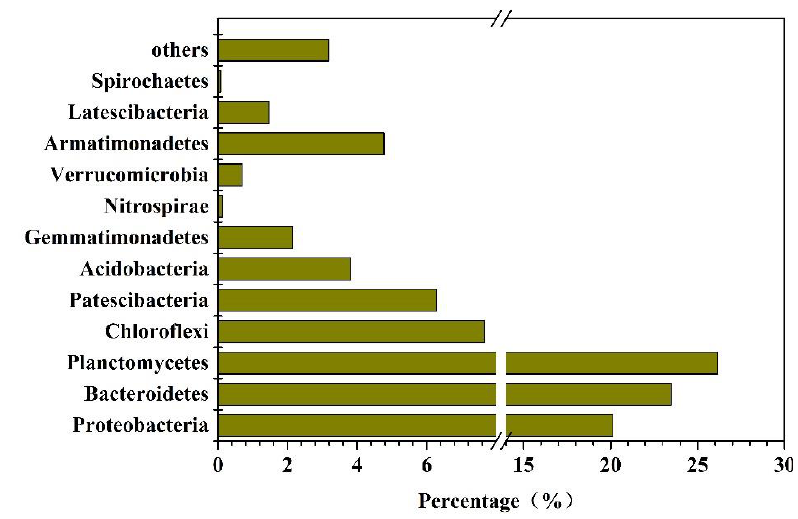
Figure 6. Bacterial abundances in the MBBR on the phylum level. Table 2. Nitrogen-metabolism-related bacteria and their abundances in the MBBR.